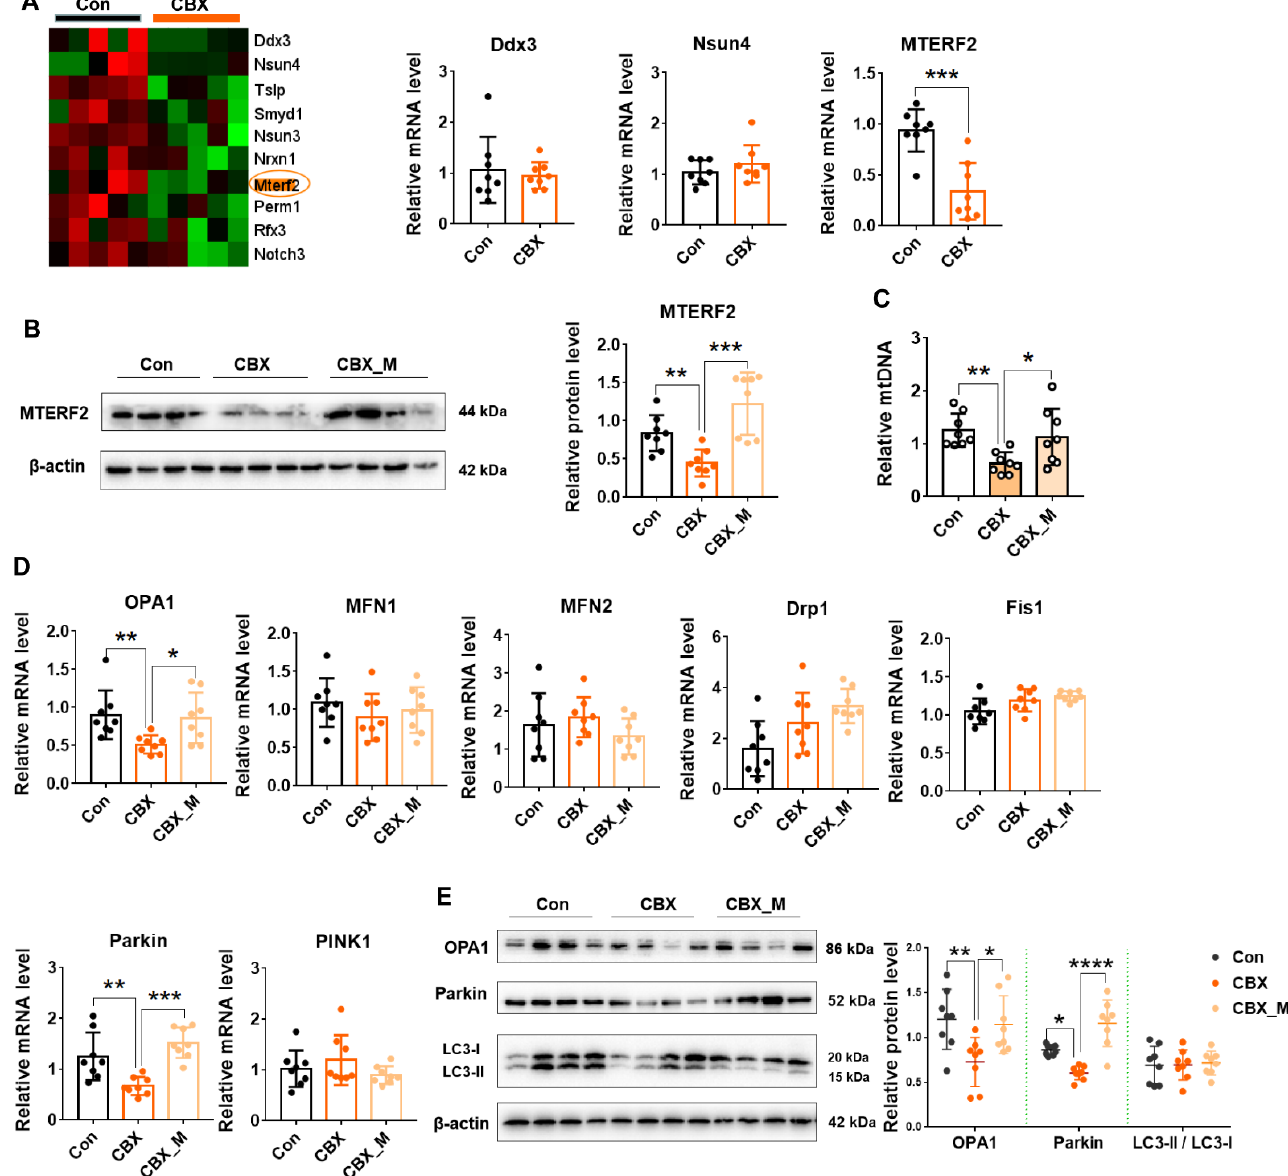
Figure 4. MitoTEMPO improves MtDNA stability and mitochondrial dynamics in the placentas of PE-like model. Pregnant rats were administrated with CBX, CBX combined with mitoTEMPO or saline from GD 7.5 to GD 17.5. The rats were sacrificed on GD 20.5 for collection of blood and pla- cental tissues. ( A ) the transcriptional levels of the genes that control mtDNA maintenance. Left panel : heatmap of the genes related to mtDNA maintenance in RNA-seq. Right panel : cumulative data of Q-PCR analysis. ( B ) MTERF2 protein expression level. ( C ) mtDNA copy number. ( D ) the mRNA levels of mitochondrial dynamic genes. ( E ) protein levels of OPA1, Parkin and LC3. Left panel : representative images of Western blotting. Right panel : cumulative data of each protein expression level. * p < 0.05, ** p < 0.01, *** p < 0.001, **** p < 0.0001. Con: control; CBX_M: CBX combined with mitoTEMPO treatment. Given that mitochondria undergo autophagy and fusion/fission from time to time in order to maintain their proper functions [31], we then investigated whether mitochon- drial dysfunction is associated with impaired mitochondrial dynamics. The mRNA lev- els of Mfn1, Mfn2, Drp1, Fis1, PINK were not significantly changed in the PE-like group (Figure 4D). The mRNA levels of OPA1, a protein of inner membrane responsible for mitochondrial fusion, and Parkin, an autophagy-related molecule, were significantly